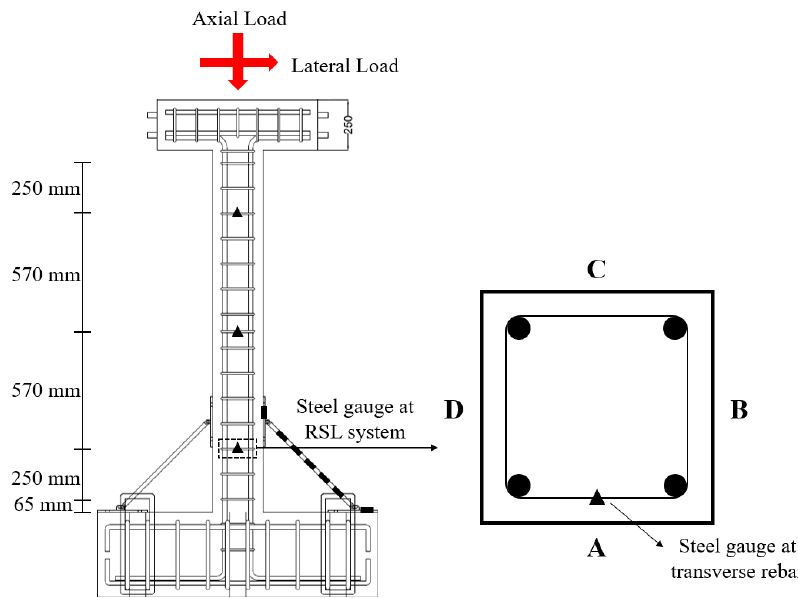
Figure 5. Loading Protocol.